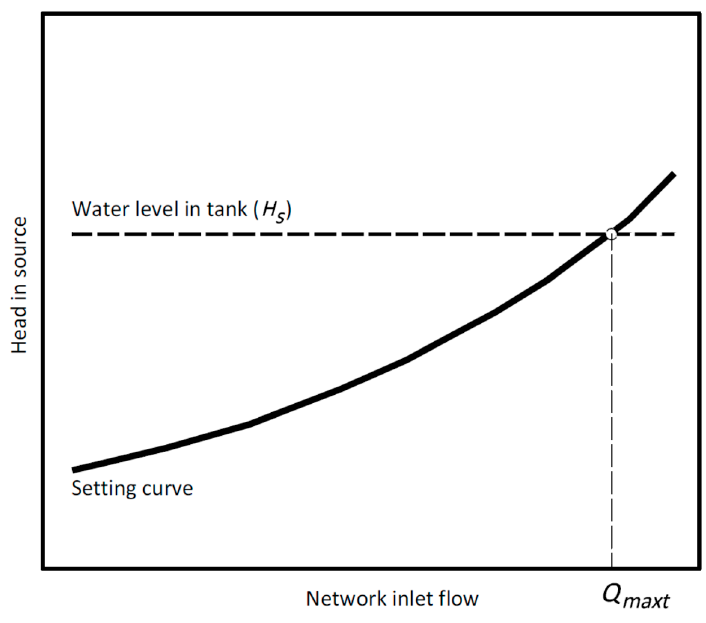
Figure 1. Theoretical maximum flow for a tank fed network [30].